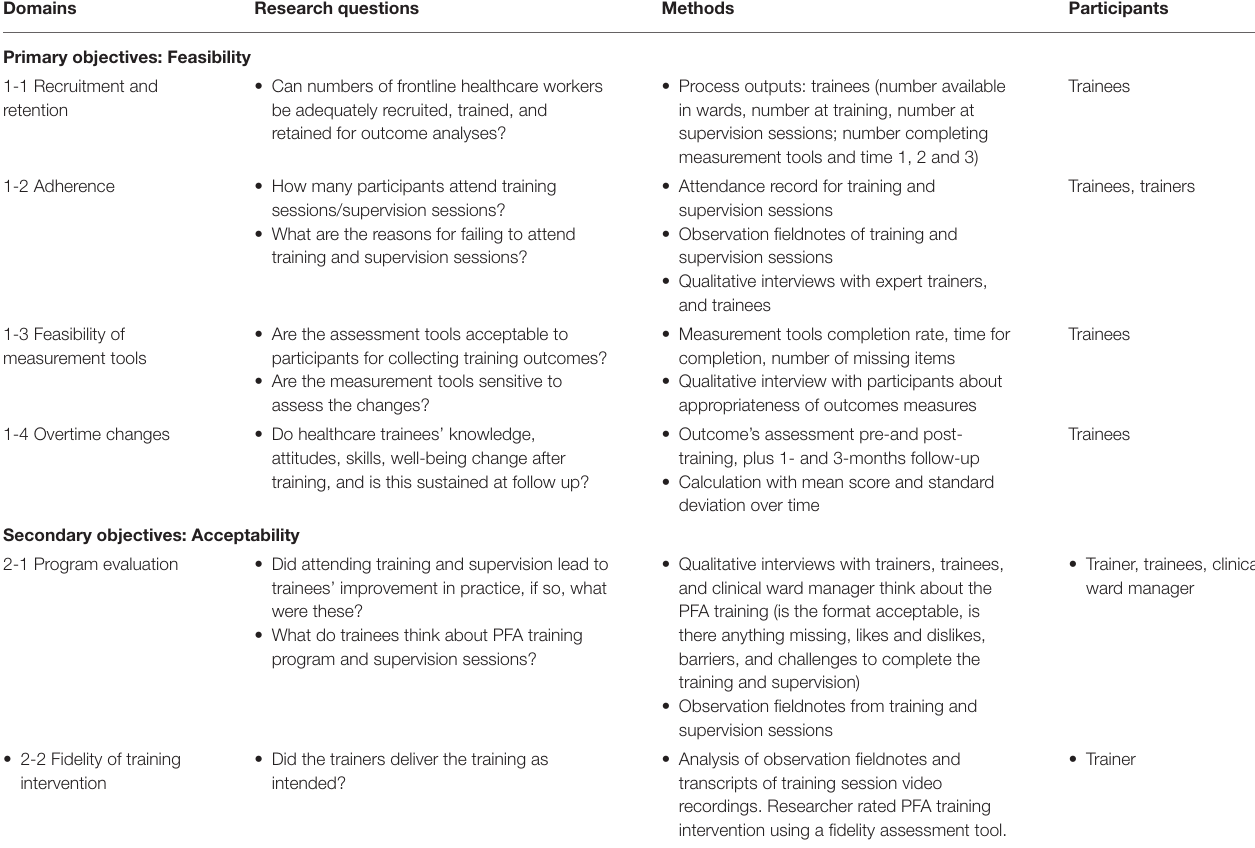
TABLE 2 | Study objectives: Feasibility and acceptability.